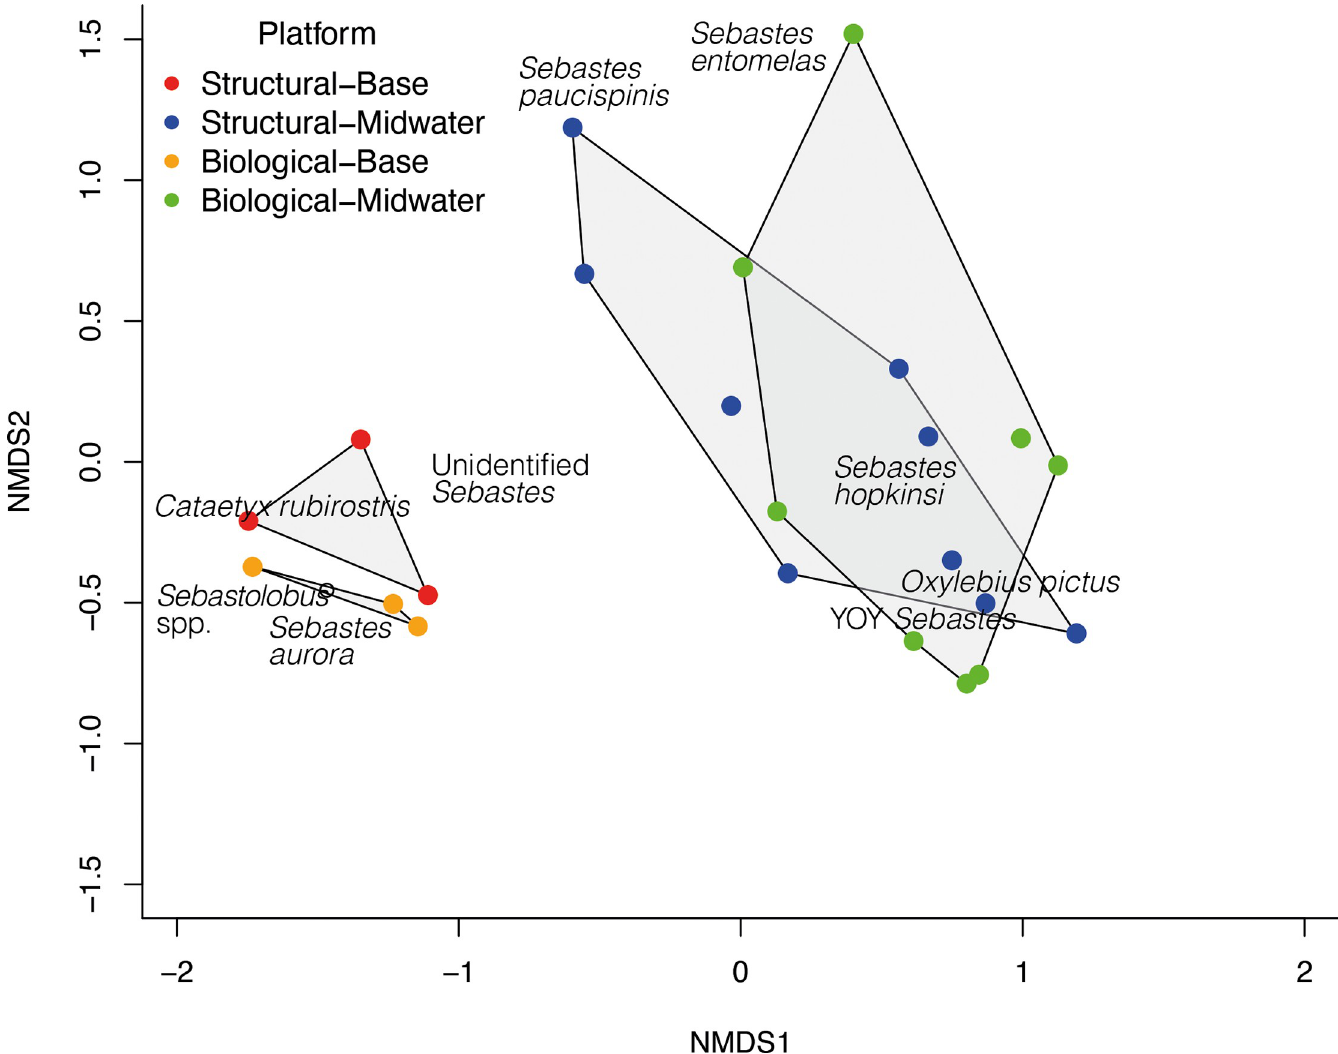
Fig 3. NMDS plot of the 10 most abundant species (83% of all fishes) observed at Platform Harmony from the ROV